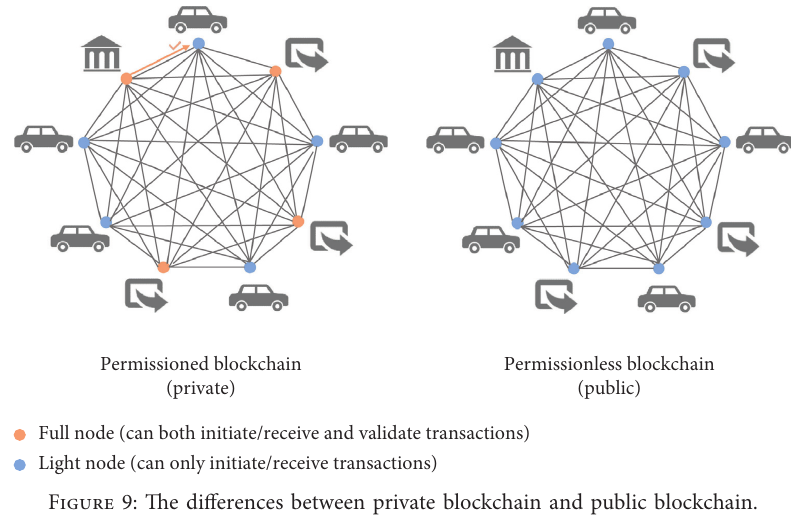
Figure 9: The differences between private blockchain and public